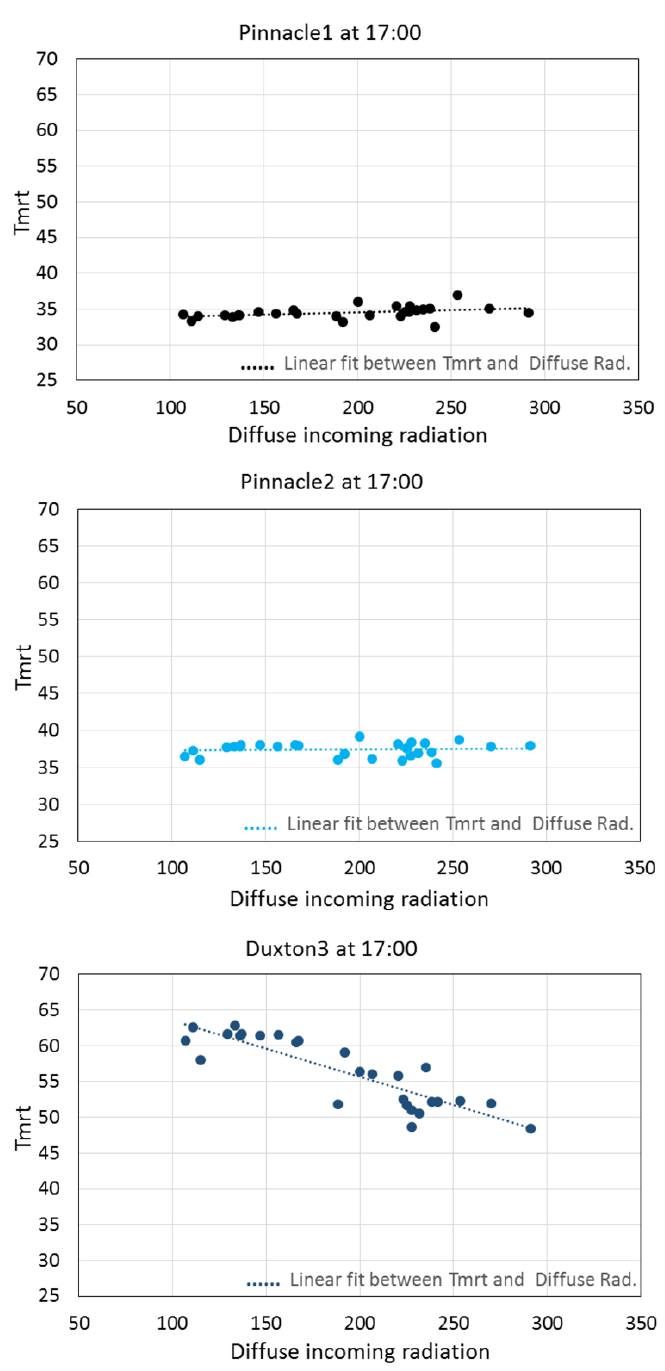
Figure 9. Relation between T mrt ( ◦ C) and diffuse solar radiation (Watt/m 2 ) in the shaded sites (Pinnacle1 and Pinnacle2) and non-shaded site (Duxton3) in the late afternoon during August 2019 (days with precipitation before 17:00 are not considered)